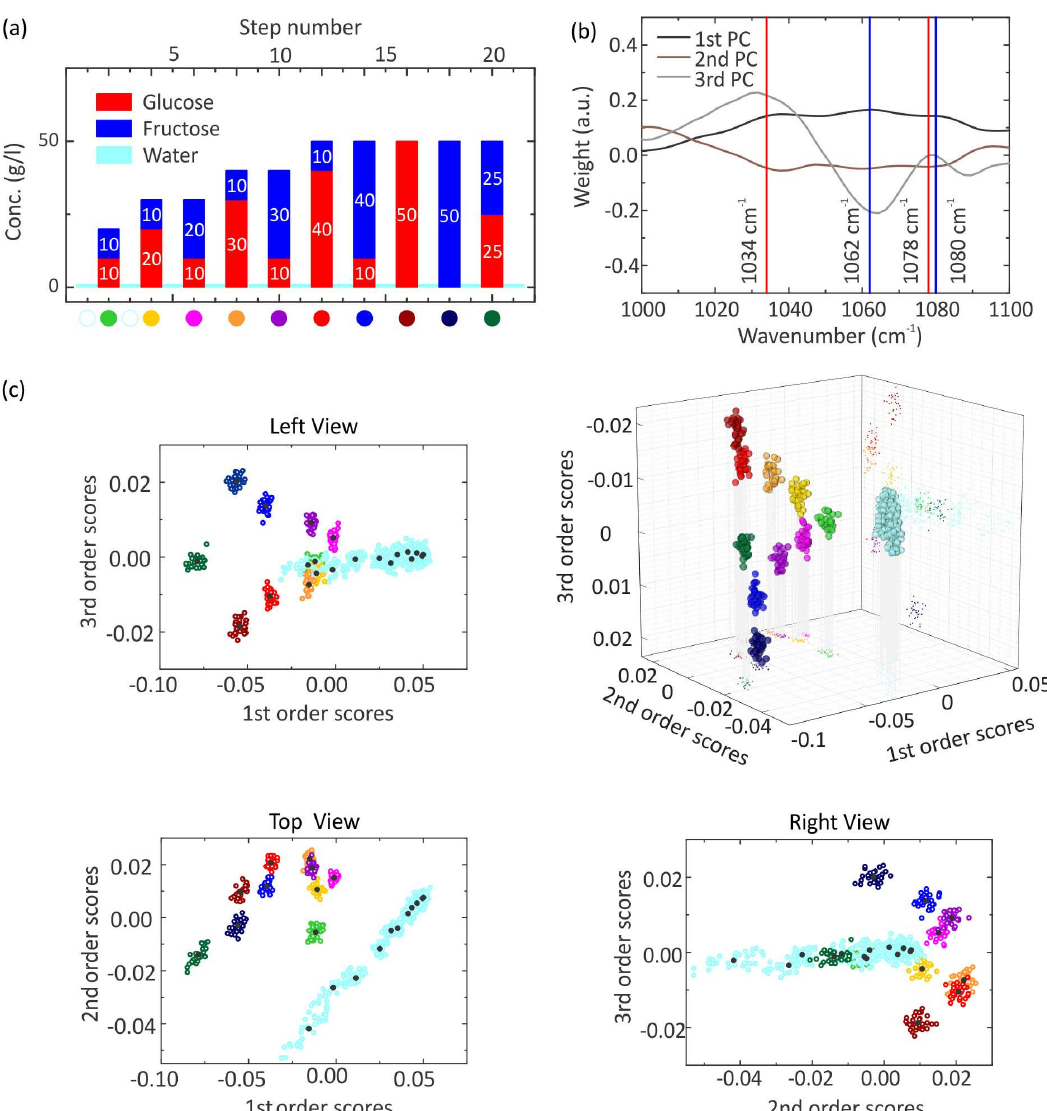
Figure 4. ( a ) Measurement cycle of pure and mixed aqueous sugar solutions of glucose and fructose as well as water, where 30 spectra are taken for each step. The red bars indicate the concentration of glucose in the solution, the blue bars of fructose, and the cyan bars of water. ( b , c ) PCA of the measured spectra from ( a ). ( b ) The PCs of the 1st, 2nd, and 3rd order are plotted against the wavenumber. The 3rd PC (gray) contains the vibrational information. The red lines indicate the vibration mode of glucose at 1034 cm − 1 and 1078 cm − 1 and the blue lines of fructose at 1062 cm − 1 and 1080 cm − 1 . ( c ) A 3D plot of the 1st, 2nd, and 3rd order scores is generated as well as the corresponding 2D plots. Each measurement step is color-coded, where water has the same color and the other solutions have an individual color that is indicated at the bottom of the measurement cycle in ( a ).